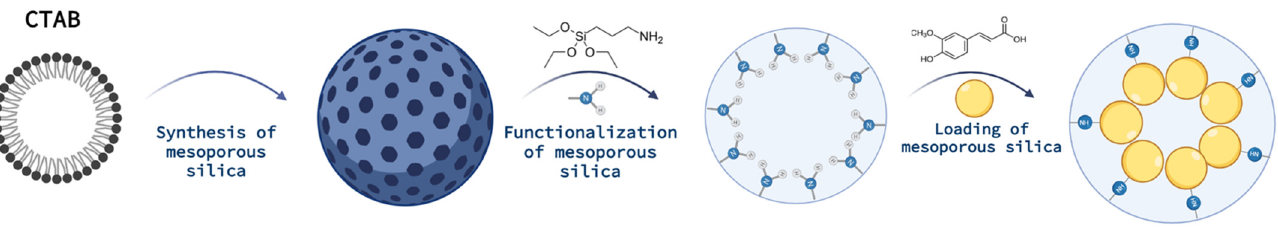
Table 1. Types of mesoporous material loaded with trans-ferulic acid (FA).